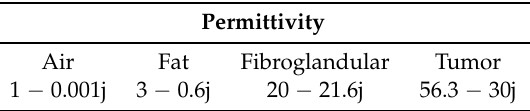
Table 1. Complex permittivity for different tissues.